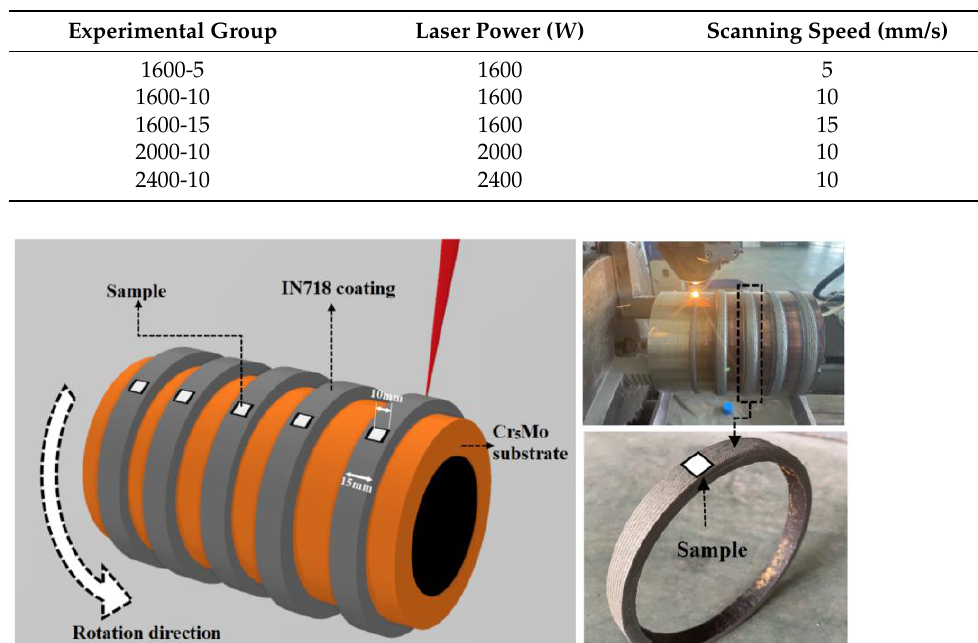
Figure 1. IN718 powder characterization: ( a ) SEM image of nearly spherical powder and ( b ) particle- size distribution.